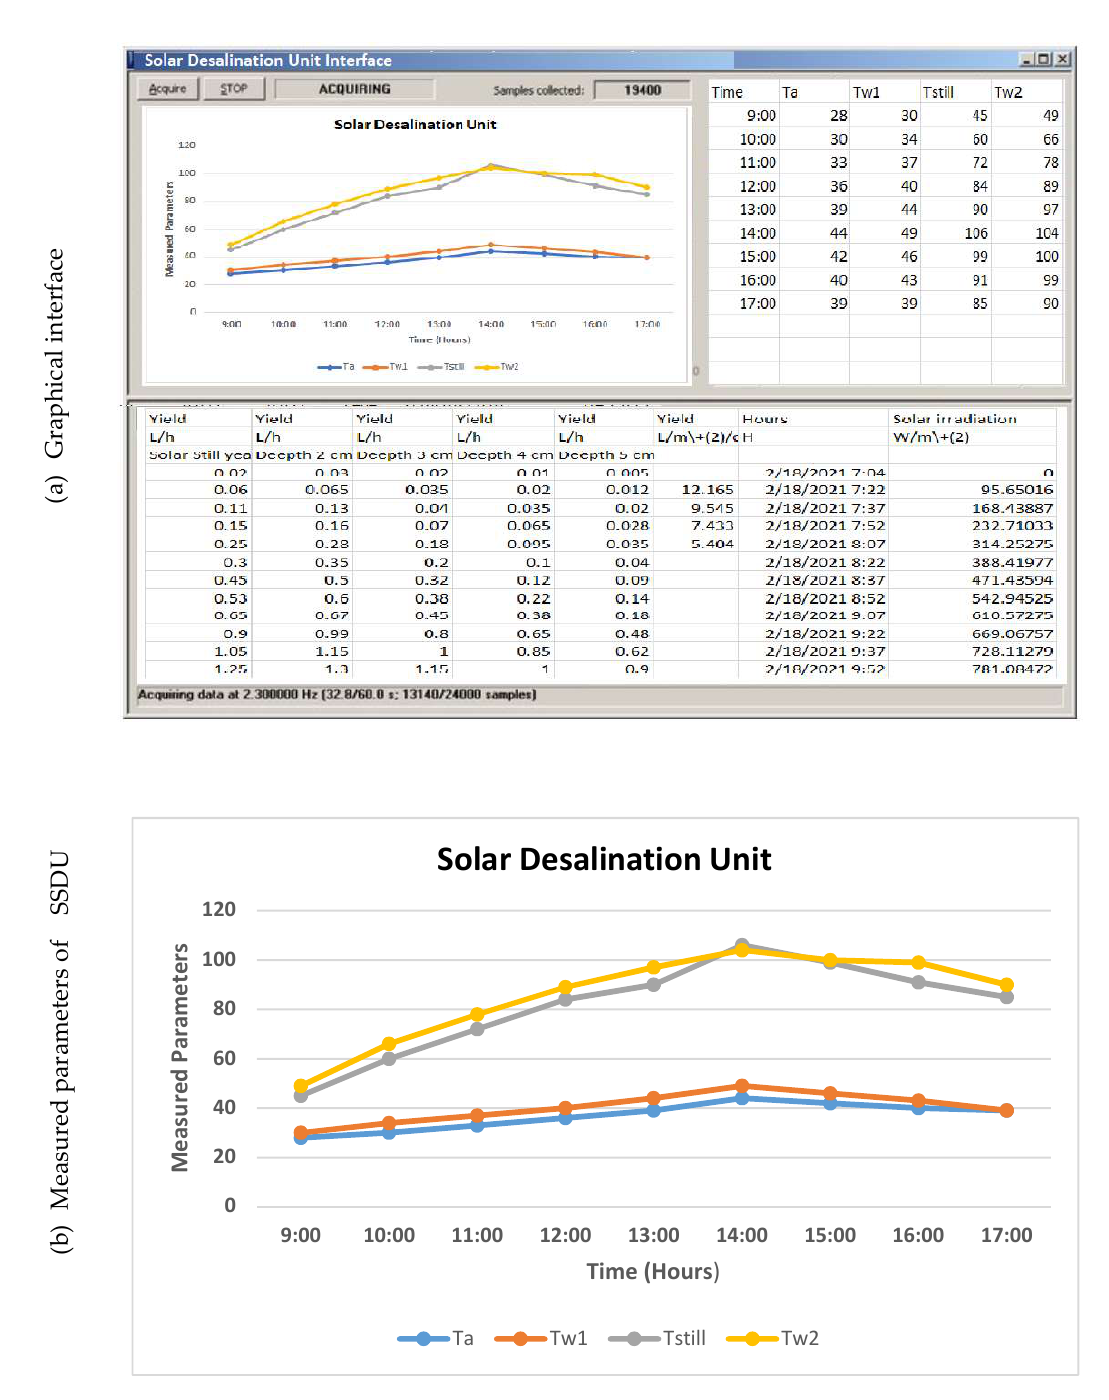
Figure 9. The main webpage of the solar still desalination unit (SSDU). ( a ) Graphic interface, ( b ) measured parameters, Ta, Tw1, Tstill and Tw2, on 18 February 2021